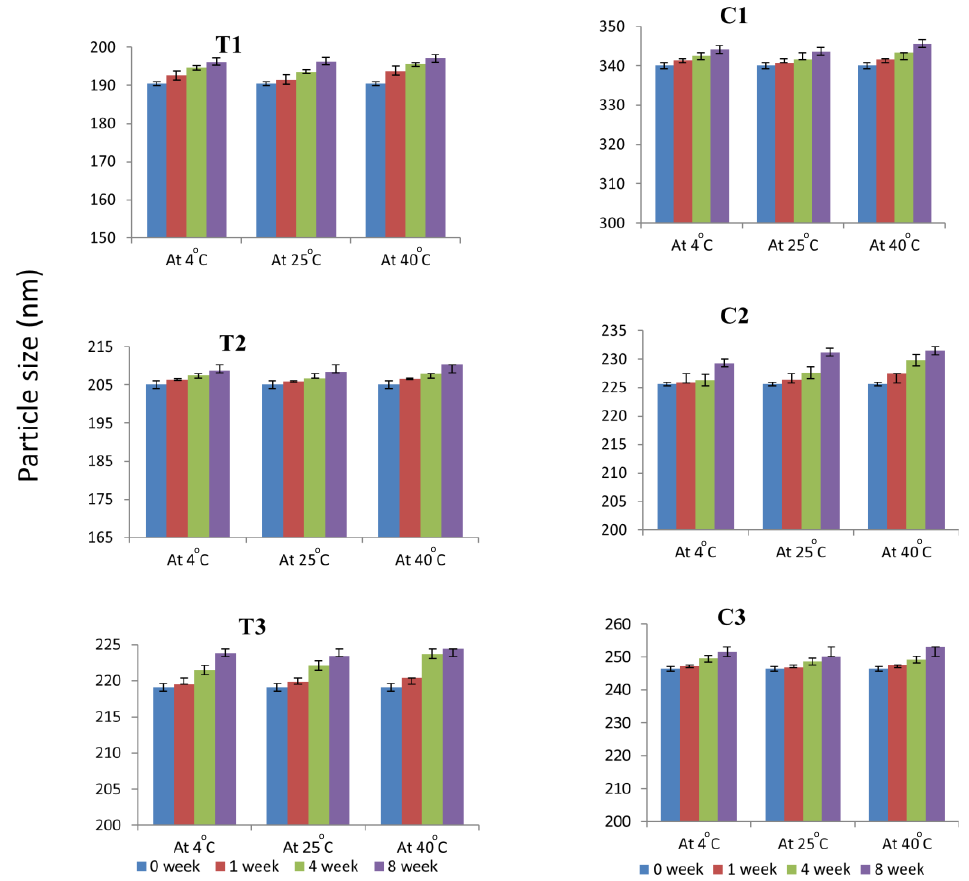
Figure 4. Particle size of microemulsion formulations at 0, 1 week, 4 weeks and 8 weeks interval at 4 °C, 25 °C and 40 °C. Mean ± SD, n=3.